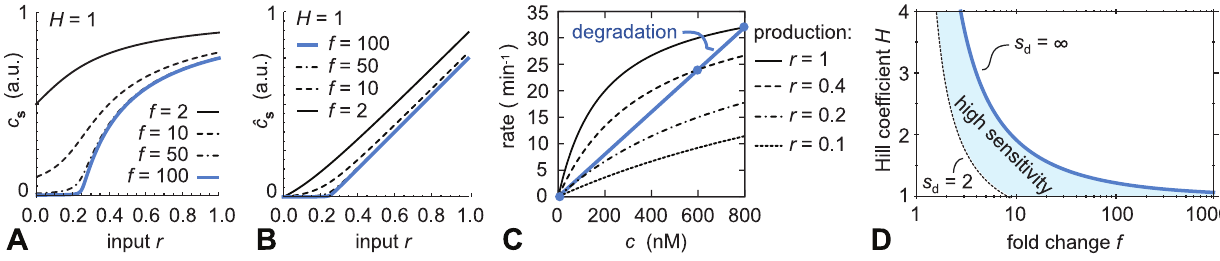
Figure 3. Auto-activation, even if non-cooperative, can strongly increase the sensitivity of the circuit. Fig. A: TF concentration c s as a function of r , for the non-cooperative auto-activation circuit ( H ~ 1 ). For large values of the fold-change f the plot becomes a highly effective threshold response, with threshold r ~ K = c max , here set to 0.25. Fig. B: Same as Fig. A, but now showing the response of the active species, ^ cc s ( r ) , which at large f becomes threshold-linear. Fig. C: Graphical explanation of the threshold response at large f . Plotted are both the degradation and the production rate of the TF, as a function of the TF concentration c (see Eq. 1). The intersections between these curves (indicated with dots) indicate the steady state level c s . When r is high, the steady state expression level of c is high. However, when r is reduced below K = c max the expression is fully turned off. Fig. D: Phase diagram of the sensitivity, defined as the maximum slope in a log–log plot s d (similar results are obtained using an alternative definition s D ; see Supplementary Text S1). Above the solid, blue line the system is bistable (see Fig. 1); on this line s d diverges. To obtain a high sensitivity, one therefore has to choose the parameters close to this line, in the shaded region (we use the arbitrary cutoff s d ~ 2 ).